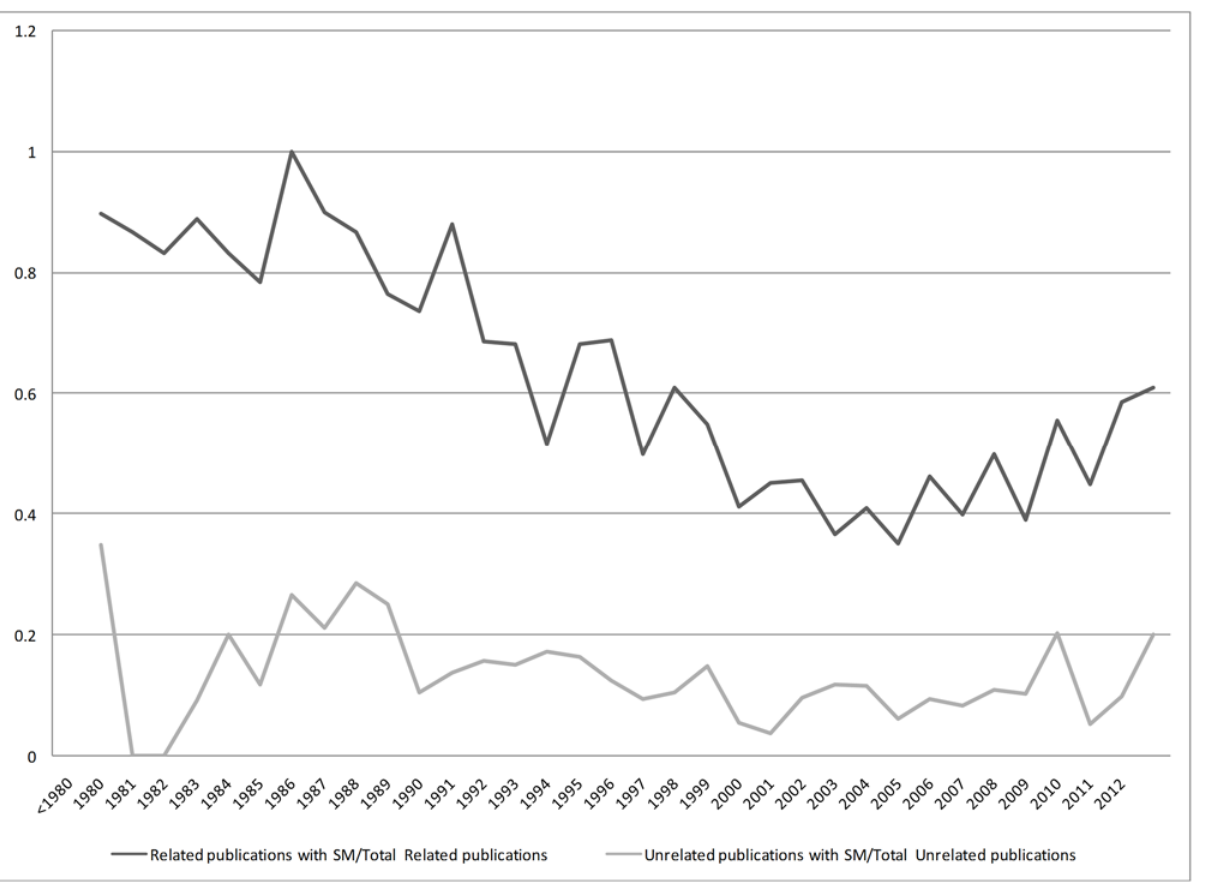
Fig 3. Proportion of Related and Unrelated Publications Which Used SM Terms in Their